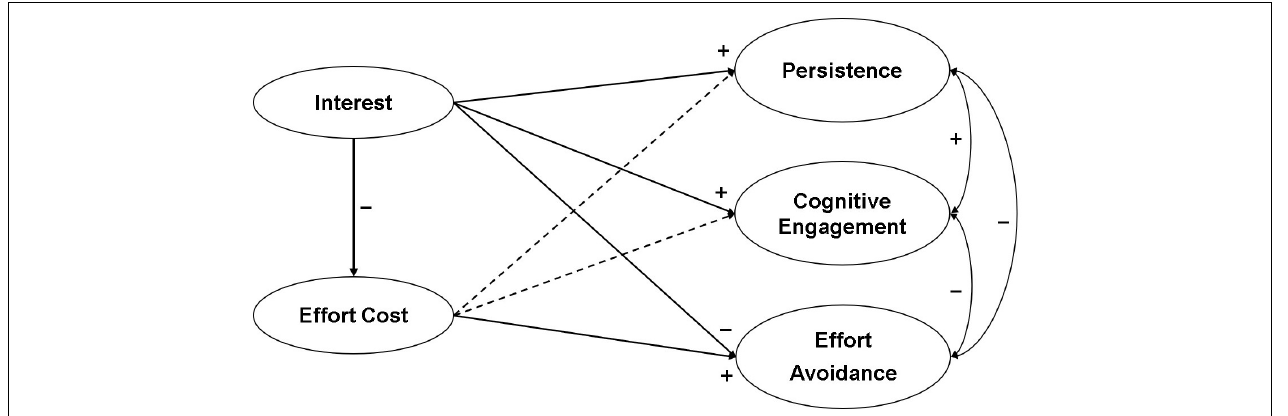
FIGURE 1 | A hypothesized model. Dashed lines indicated a nonsignificant path. For clarity, indicators, measurement errors, and disturbance terms are not presented.